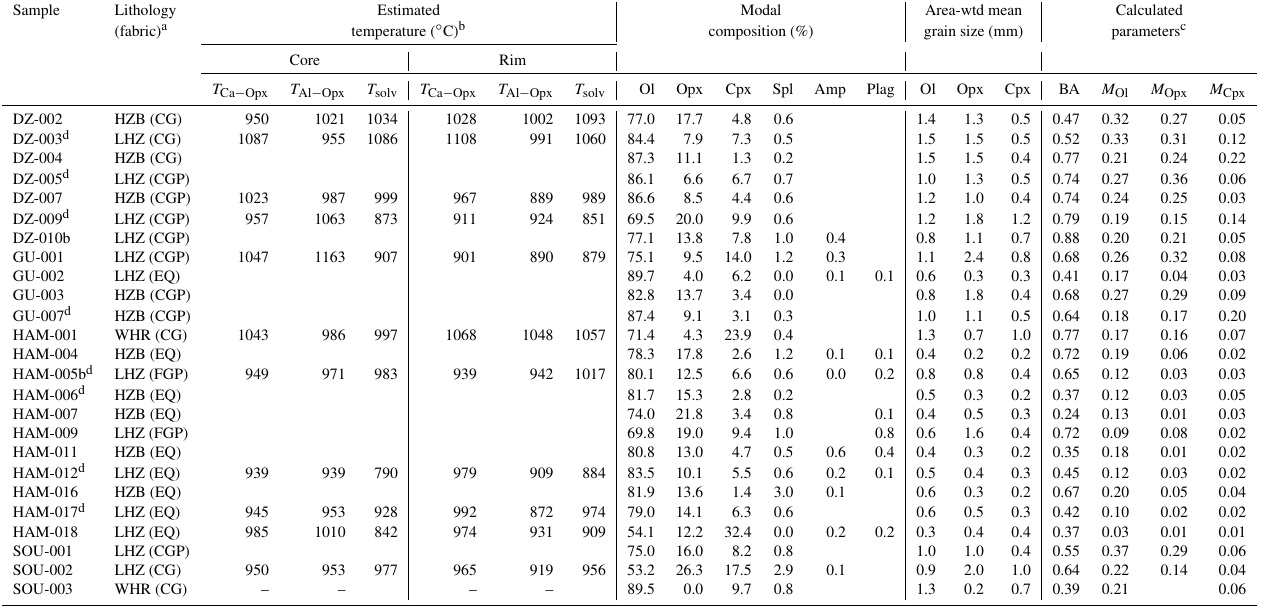
Table 1. Summary of petrography, estimated temperatures, modal composition and calculated microstructural parameters in the Oran mantle